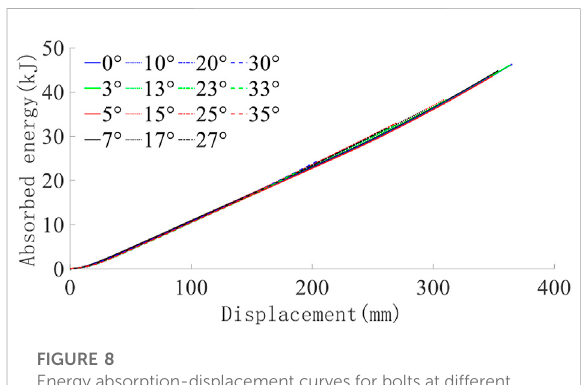
FIGURE 8 Energy absorption-displacement curves for bolts at different angles.